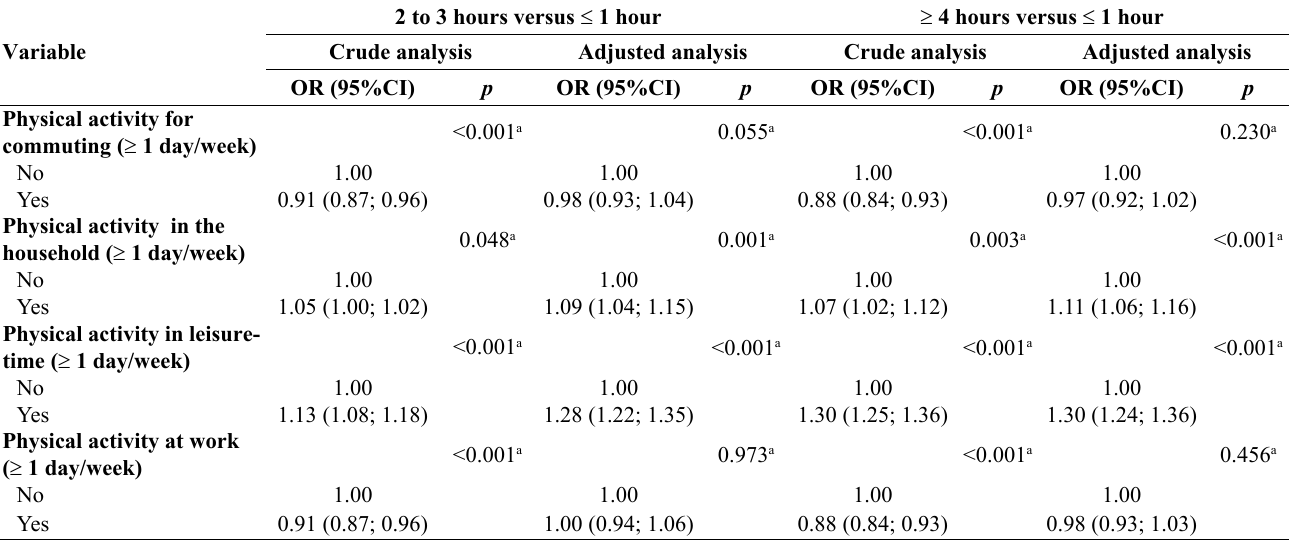
Table 2. Crude and adjusted relation of physical activity indicators with weekend television viewing time in industry workers. Brazil, 2006-2008 2 to 3 hours versus ≤ 1 hour Variable Crude analysis Adjusted analysis Crude analysis Adjusted analysis Physical activity for